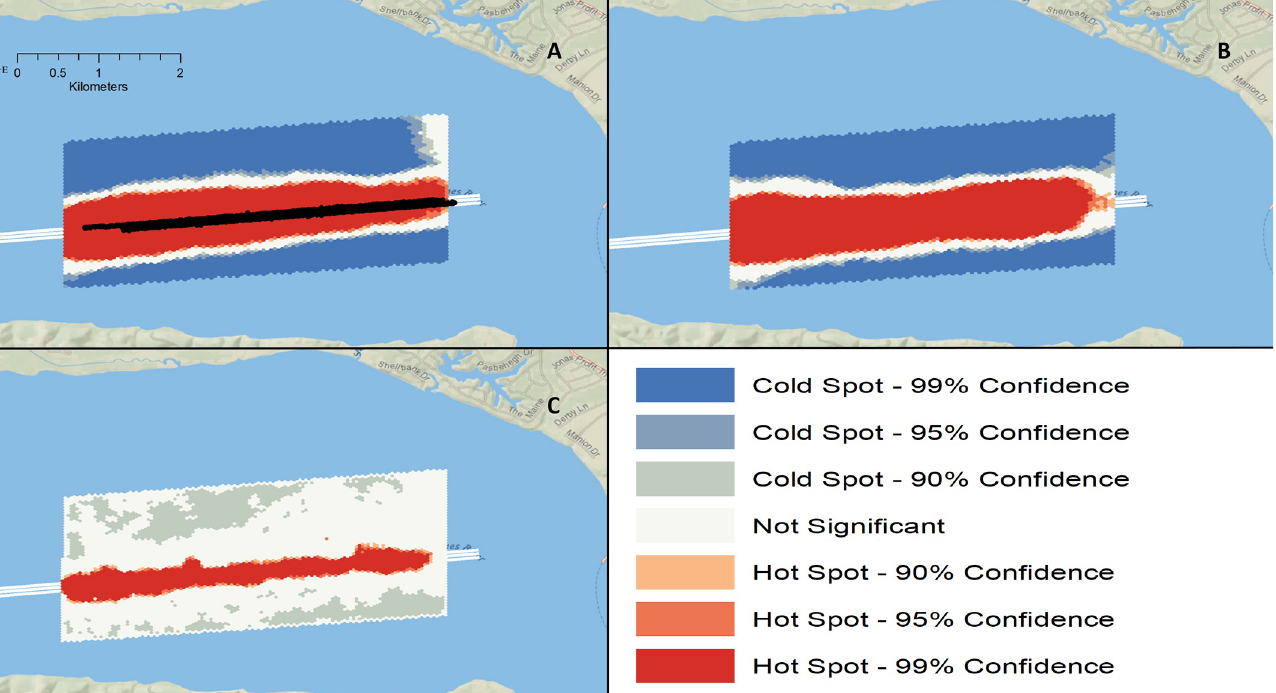
PLOS ONE | https://doi.org/10.1371/journal.pone.0230029 March 6,